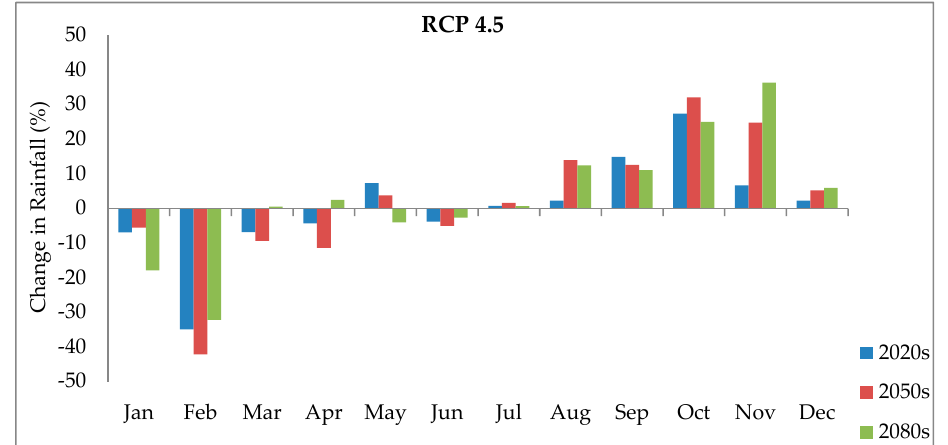
Figure 7. Change in rainfall under Representative Concentration Pathway (RCP2.6) scenario compared to the baseline (1961–1990). Water 2020 , 12 , x FOR PEER REVIEW